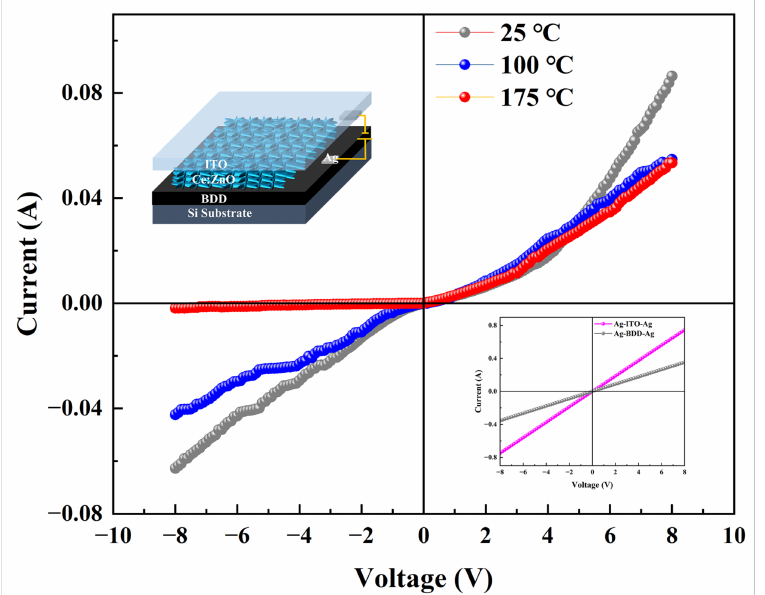
Figure 4. Current–voltage ( I–V ) characteristics of the n-Ce:ZnO NL/p-BDD heterojunction at various temperatures. The top left inset shows the device structure schematic. The lower right inset shows the ohmic contact test of Ag/ITO/Ag and